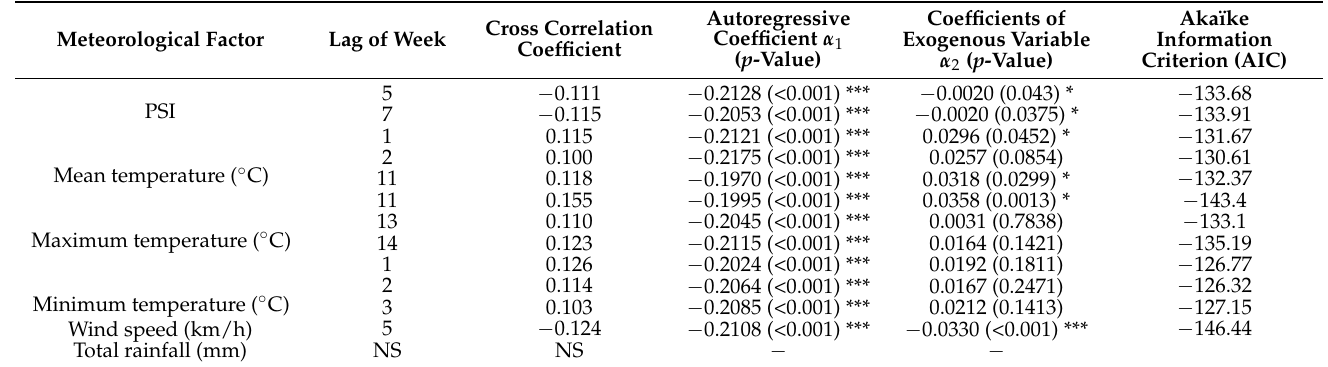
Table 2. Cross-correlation analysis and ARIMA modeling of meteorological factors to dengue